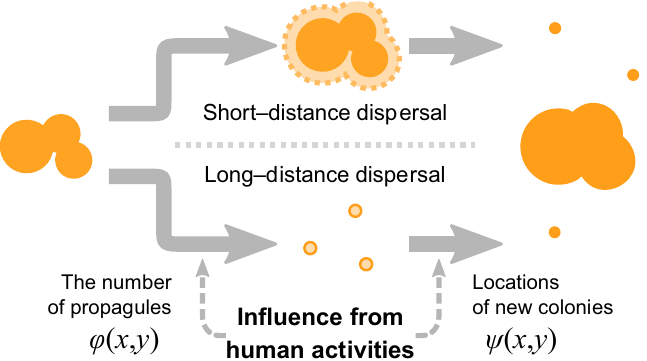
Figure 4. A schematic of short- and long-distance dispersal modes. Human activities may influence the long- distance dispersal by: (1) changing the number of propagules starting the long-distance dispersal ( R · ϕ( x , y ) ), and (2) introducing biases in their spatial locations ( ψ( x , y ) ). By compositing these short- and long-distance dispersals, we predict population establishment at the next time step.